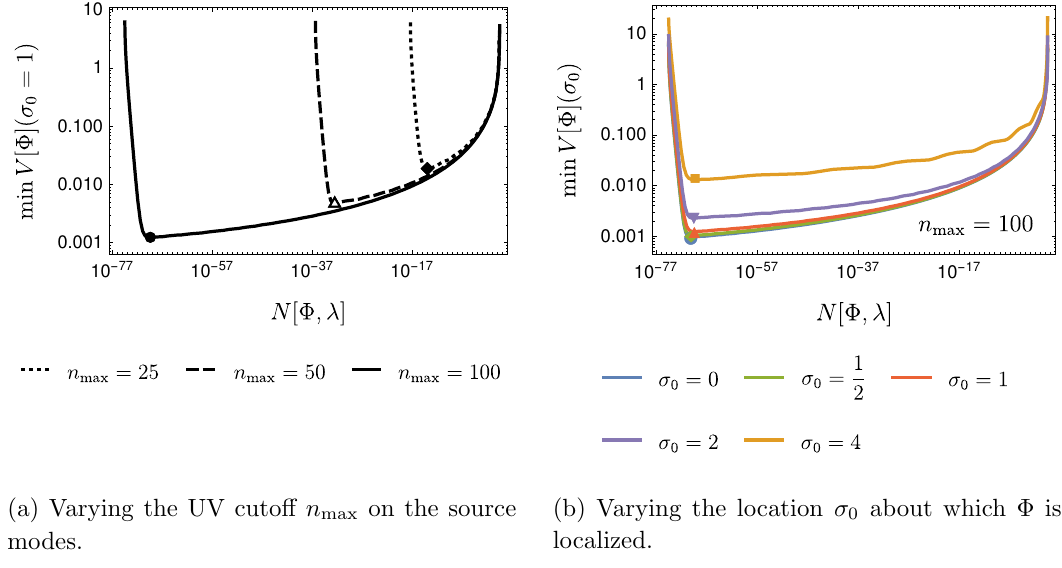
(a) Varying the UV cuto(cid:11) n max on the source modes. Figure 7. Minimization of the variance V [(cid:8)] of the initial data for (cid:12)xed ratios of L 2 norms between the initial data (cid:8) and the sources (cid:21) . Shapes mark the absolute minima of V [(cid:8)].